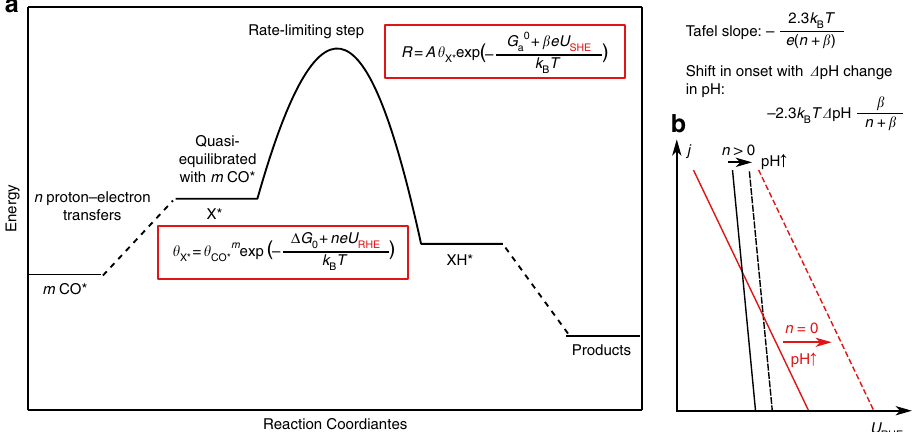
Fig. 3 The effect of pH on multistep proton – electron transfers from H 2 O. a Schematic of the reaction energy landscape of a process with multiple proton – electron steps. b Shift in the onset with pH for reactions with n = 0 and n > 0